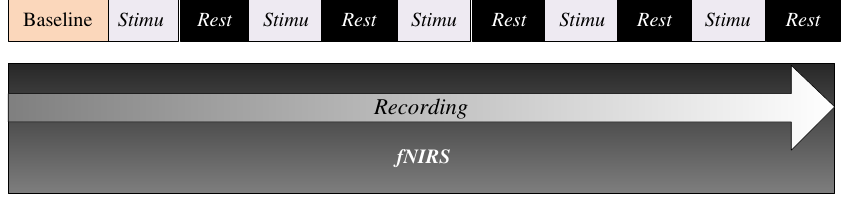
Fig. 3. Block-design paradigm of cerebral activity measurement for Monte Carlo